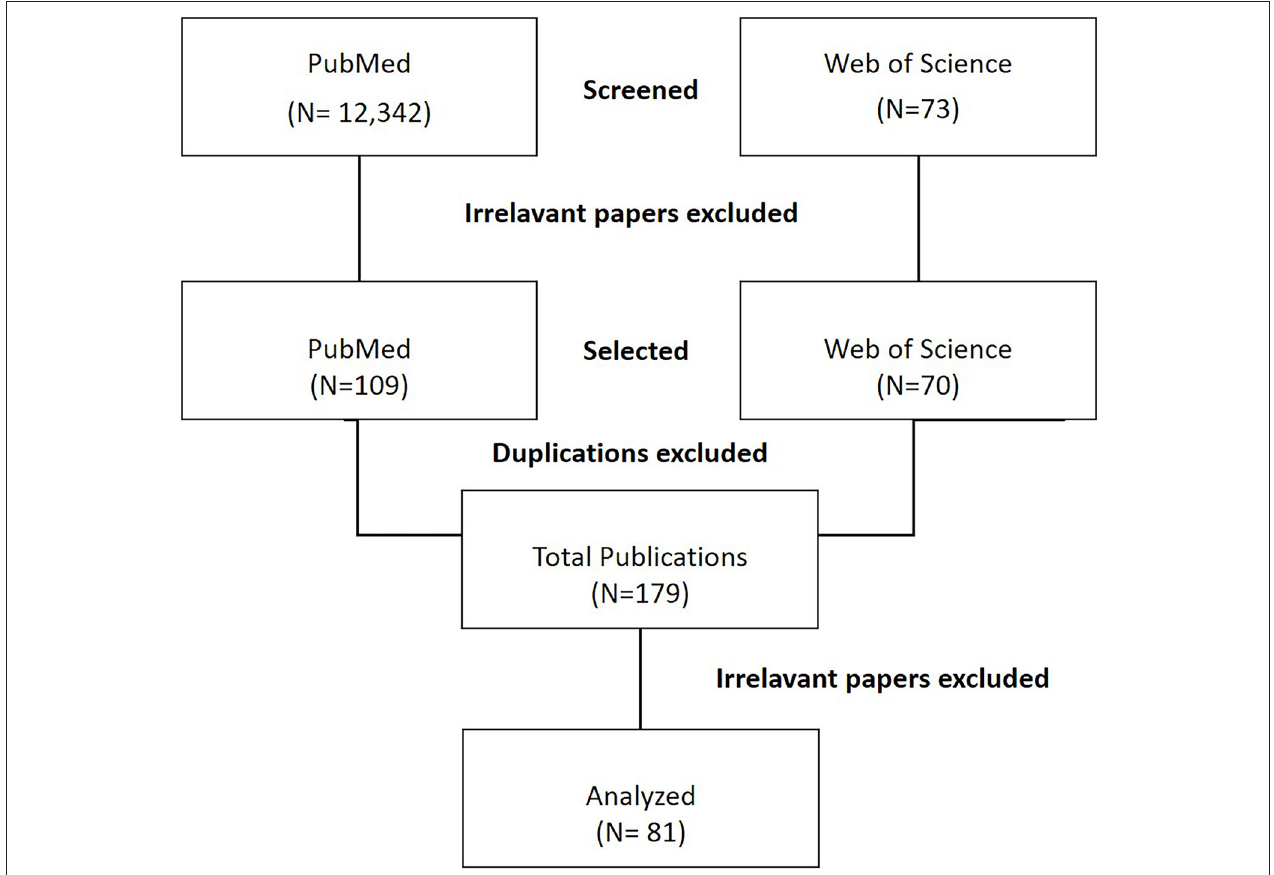
FIGURE 1 | The flowchart of the